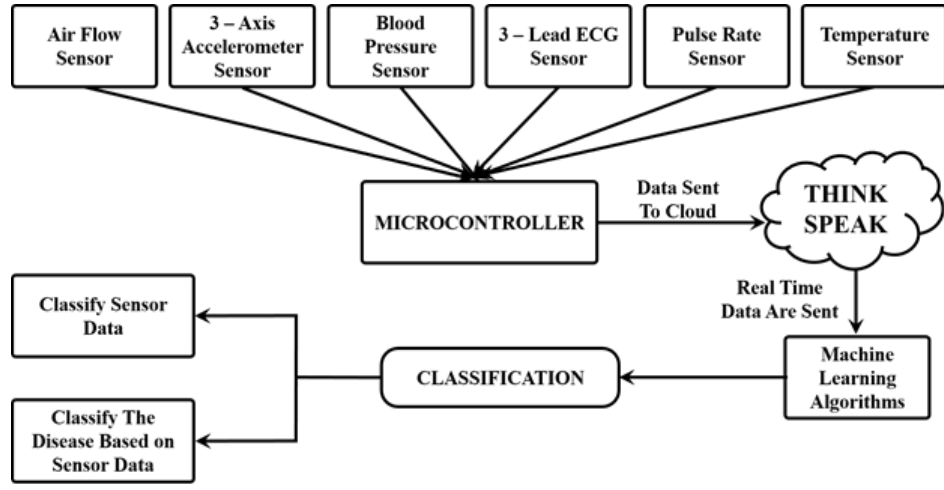
Figure 7. Machine Learning-based model via wearable sensors data for healthcare systems.